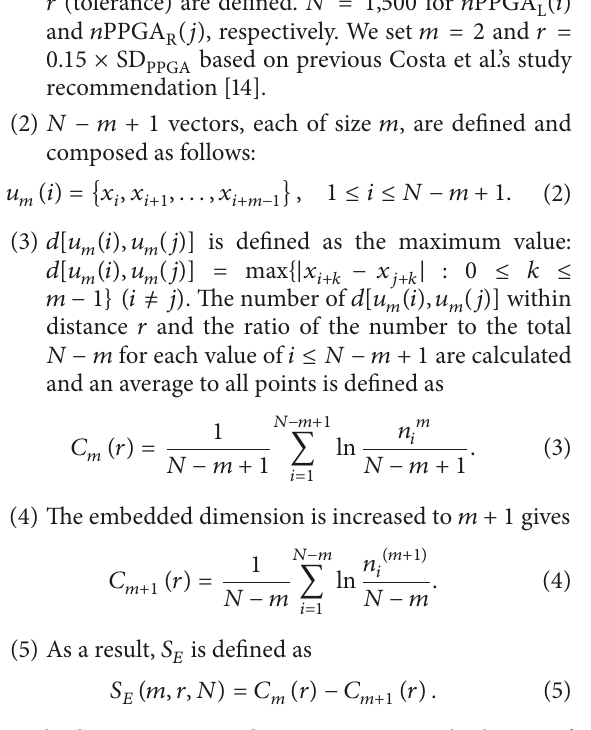
𝑟 (tolerance) are defined. 𝑁 = 1 , 500 for 𝑛 PPGA and 𝑛 PPGA R (𝑗) , respectively. We set 𝑚 = 2 and 𝑟 = 0.15